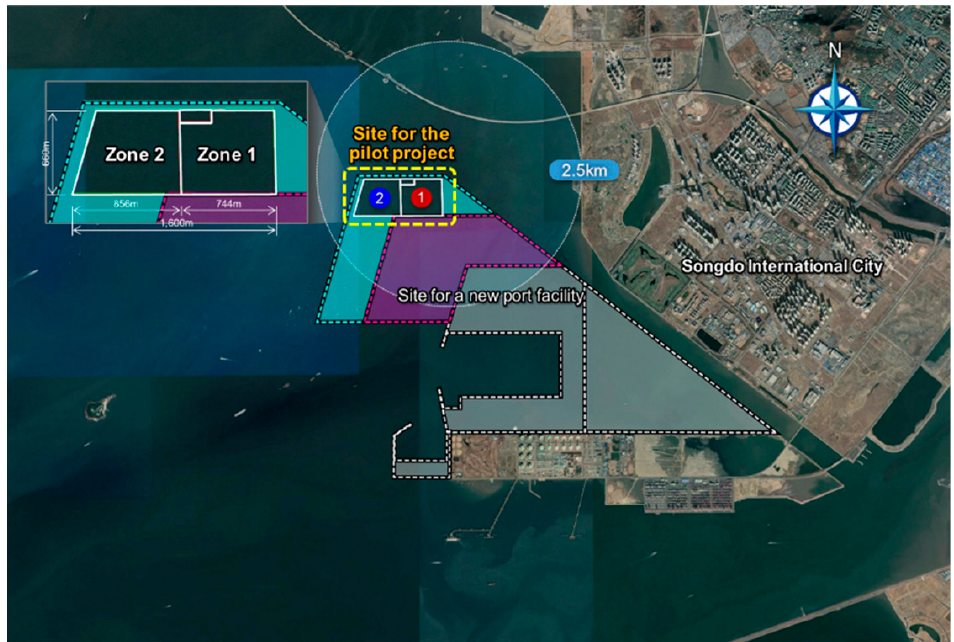
ff shore waste disposal